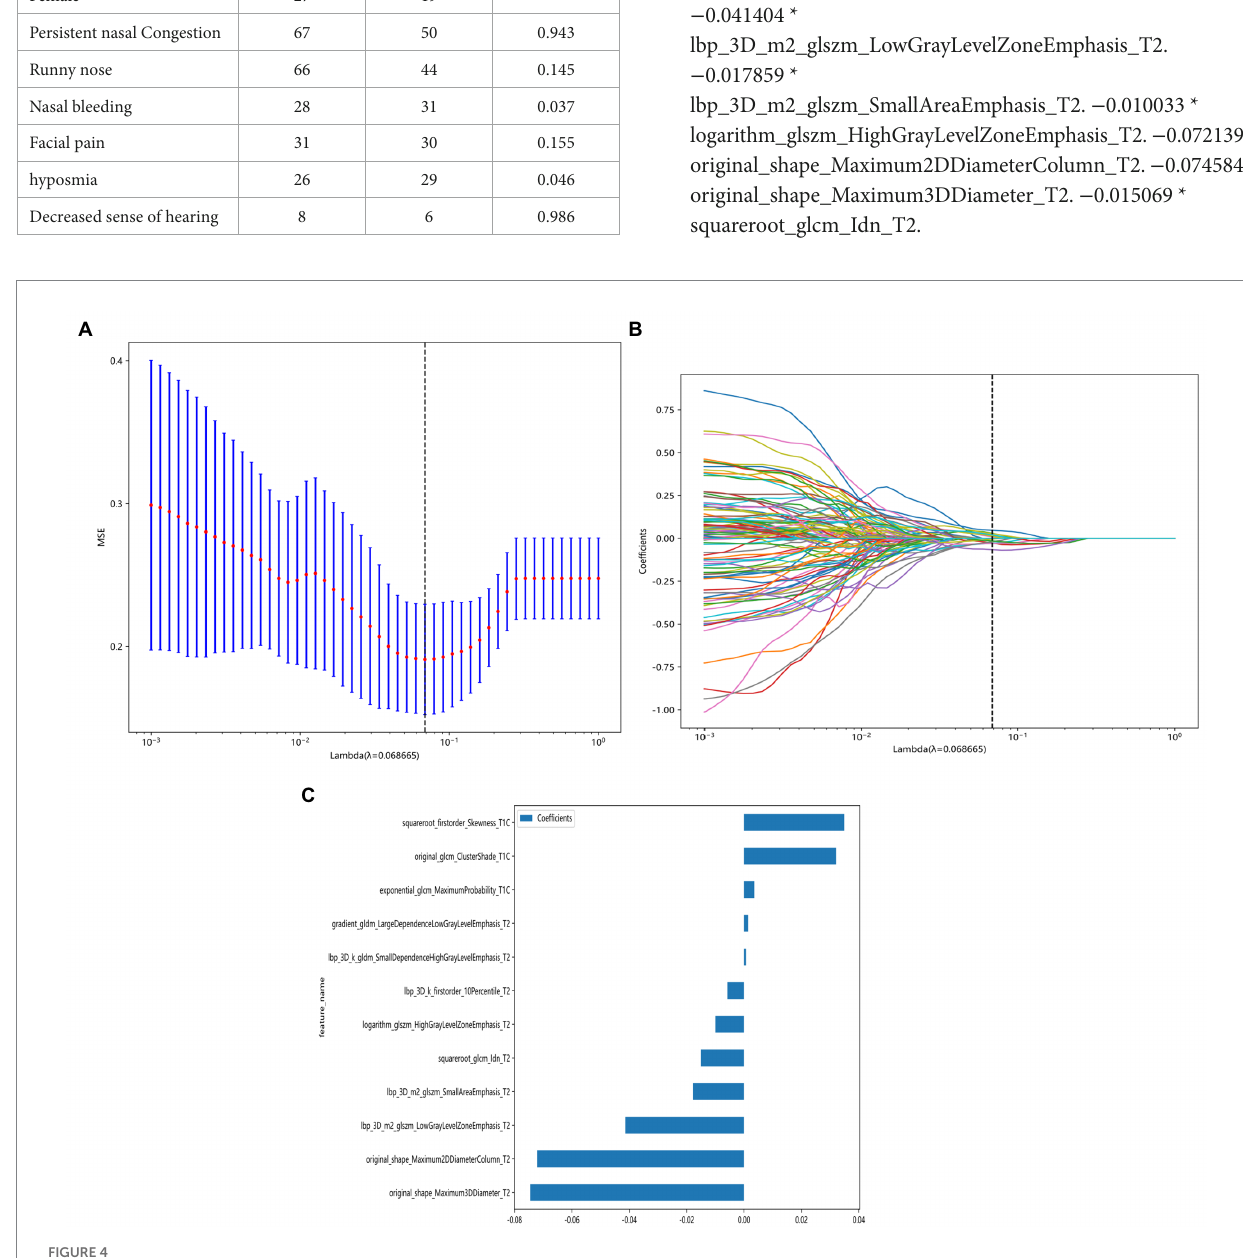
FIGURE 4 LASSO model dimensionality reduction visualization process. (A) Feature dimensionality reduction using LASSO, the horizontal coordinate indicates the value of the penalty coefficient, and the vertical coordinate indicates the change of the binomial deviation size as the value of the coefficient changes. (B) Feature dimensionality reduction using LASSO, the lower horizontal coordinate indicates the log( λ ) value, the upper horizontal coordinate indicates the number of features corresponding to log( λ ), and the vertical coordinate indicates the number of each feature’s weight coefficient. (C) Coefficient values of different radiomic signature parameters when constructing rad-score after feature dimensionality reduction using LASSO.